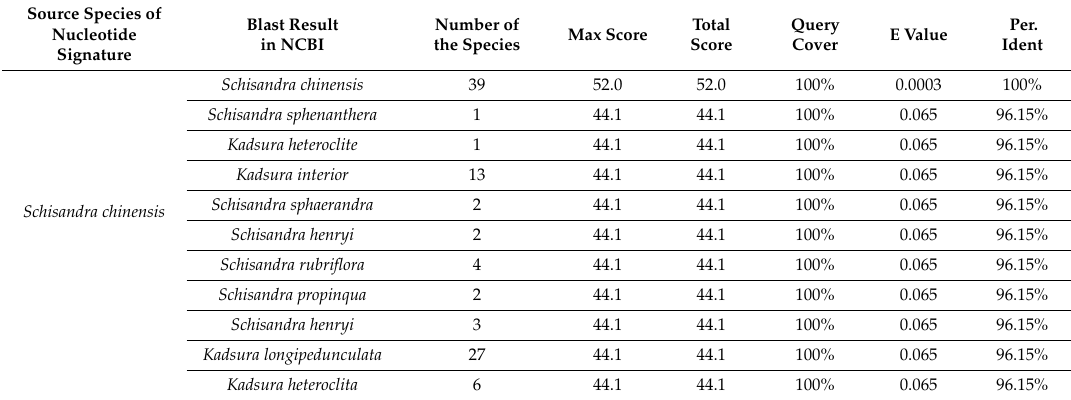
Table 3. BLAST analysis of the 26-bp unique